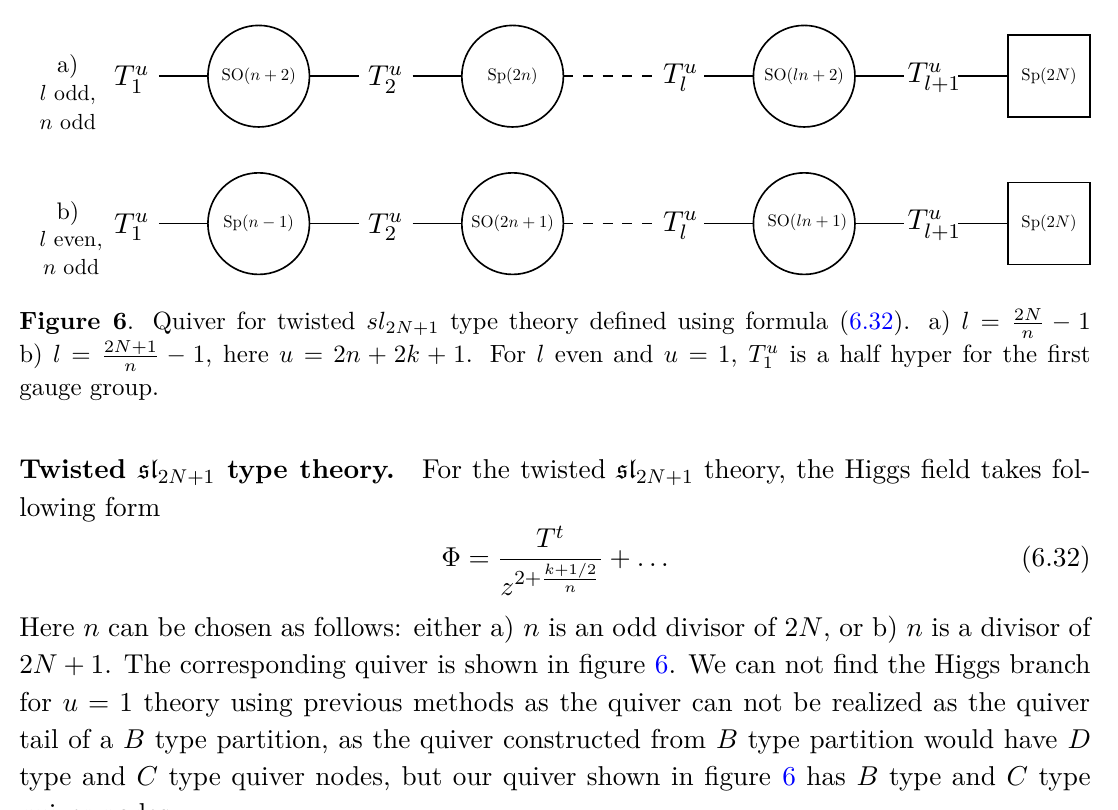
Figure 5 . Quiver for twisted sl 2 N type theory defined using formula (6.27). a) l = 2 N l = 2 N − 1 − 1 ., here u = 2 n + 2 k + 1 . When u = 1 and l odd, T u n